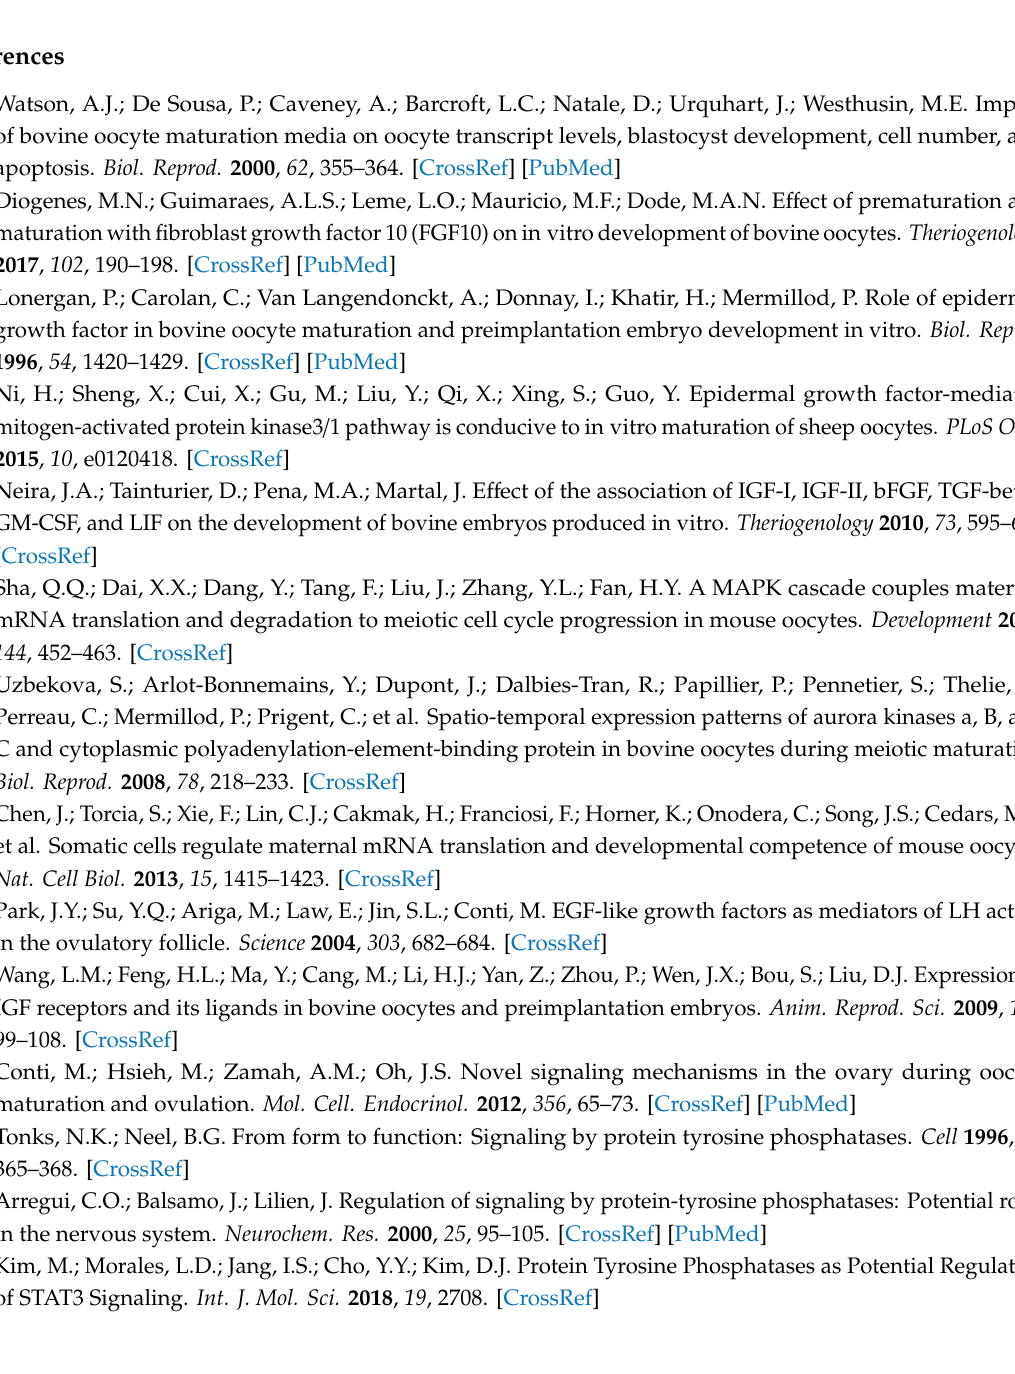
Figure S1 : Expression of SHP2 in GV and MII oocytes, and the dose dependent e ff ects of PHPS1 and Cisplatin; Figure S2 : E ff ects of PHPS1 on ROS generation, developmental arrest and ICM damage; Figure S3 : The e ff ects of SHP2 expression on GVBD induction and